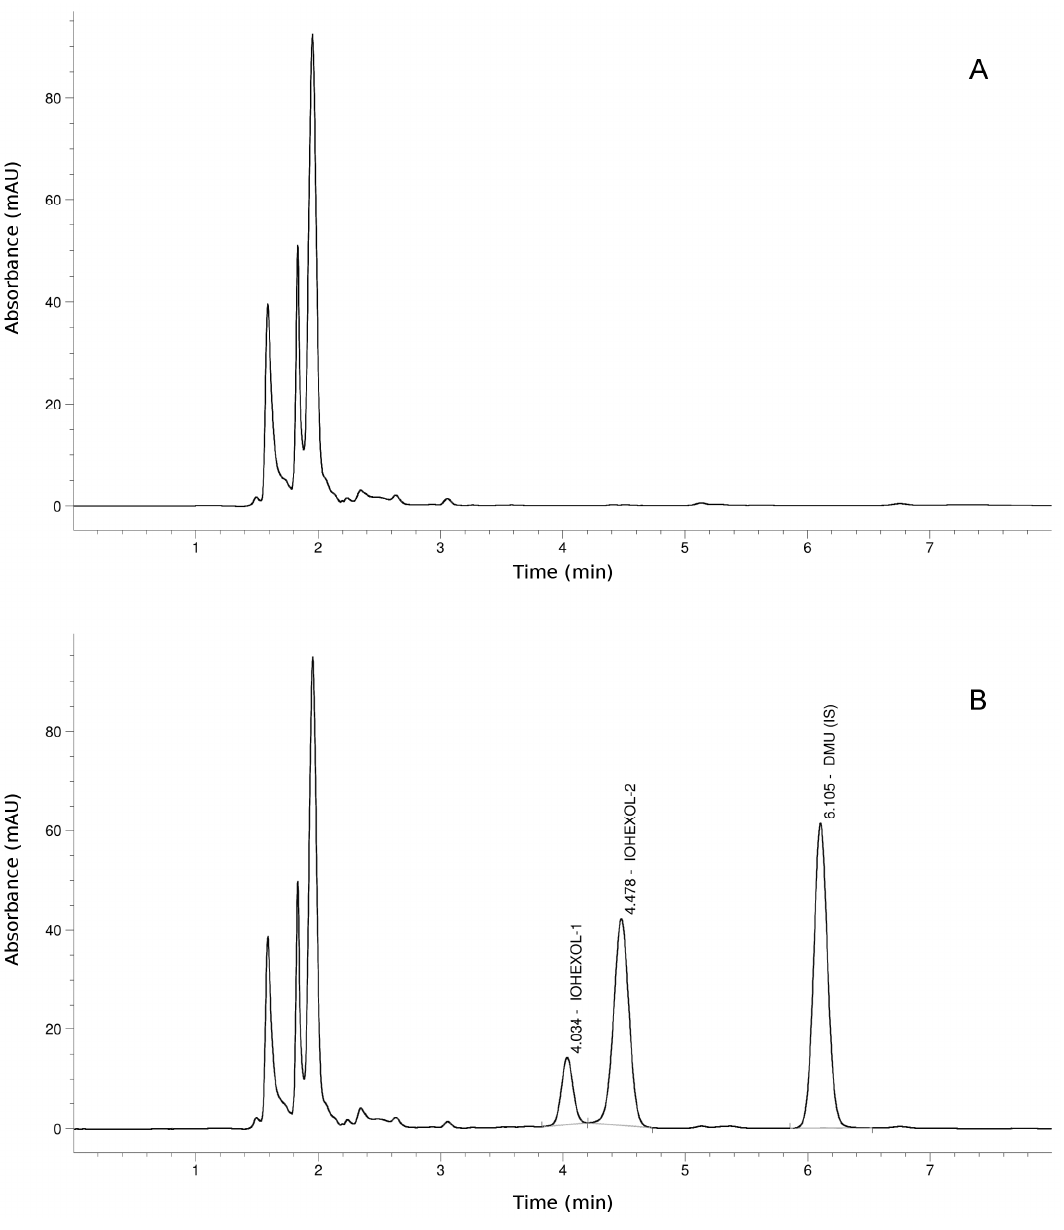
Figure 1. Representative chromatograms of swine plasma before ( A ) and after ( B ) intravenous injection of iohexol (6.47 g). Iohexol isomers and internal standard (IS) 1,3-dimethyluric acid (DMU) were detected at 254 nm.